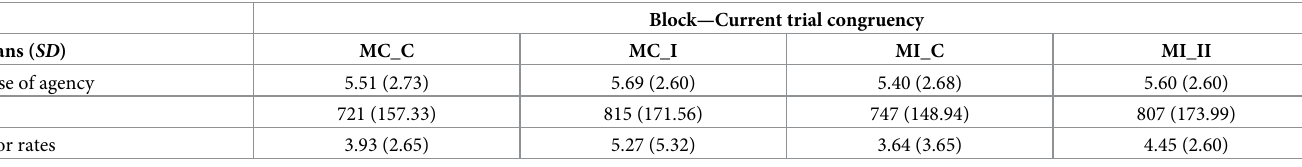
Block—Current trial congruency